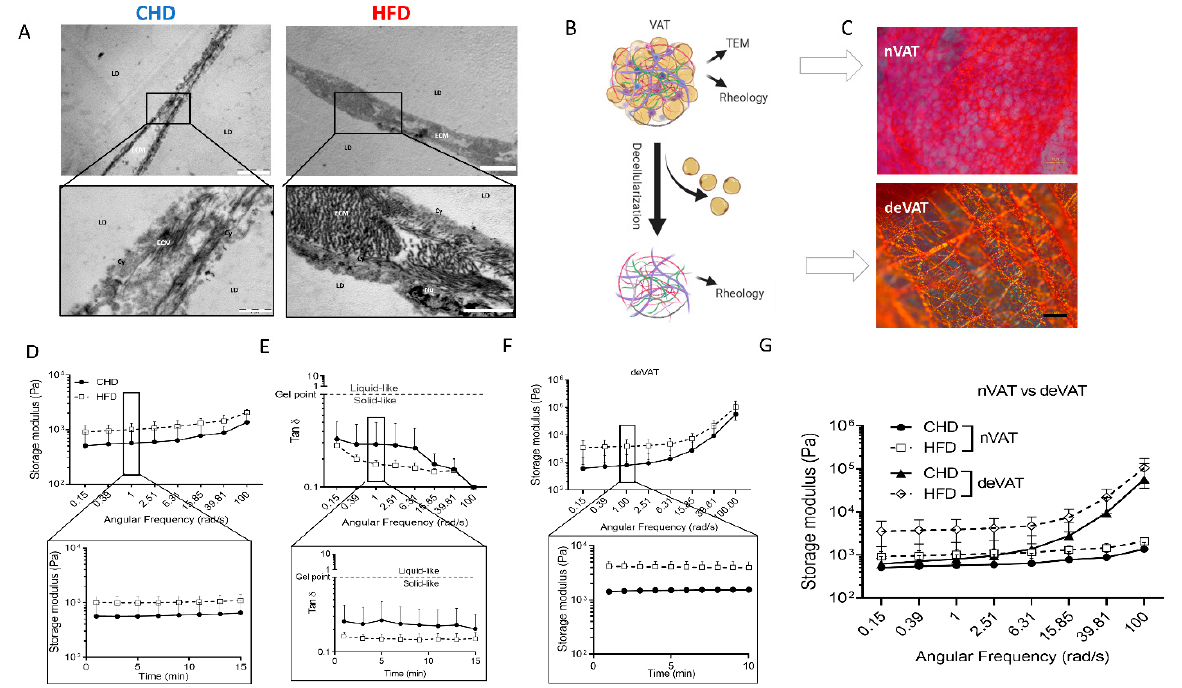
Figure 2. ECM mass and stiffness increase in VAT from HFD-fed mice. ( A ) TEM images of VAT to visualization of LDs, a thin layer of cytoplasm (Cy), and the extracellular space. Lower pictures show the ECM at high-density fibrils from HFD-fed mice, (Scale bar is 5 µ m for top images, 1 µ m for CHD, and 2 µ m for HFD-fed mice at the bottom.) ( B ) Schematic illustration of nVAT and deVAT followed collagen staining and measuring of viscoelasticity and stiffness. ( C ) Picrosirius Red Staining of nECM and deECM collagen fibers in VAT (scale bar = 100 µ m) ( D ) Storage modulus represented by logarithmic range dependent on the angular frequency sweep of mice under HFD (empty symbol, n = 5) and CHD (solid, n = 4) and the storage modulus over time under a constant angular frequency of 1 rad/ ( E ) Tan δ is dependent on angular frequency sweep or measured under angular frequency of 1 rad/s over time. The dashed grey line represents the gel point in Tan δ . ( F ) The storage modulus of decellularized VAT is dependent on angular frequency sweep for HFD (n = 7) and CHD (n = 6) and the storage modulus overtime under a constant angular frequency of 1 rad/s. ( G ) The storage modulus of nVAT compared to deVAT represents ECM stiffness. Empty symbols represent VAT from HFD-fed mice, while solid symbols are from CHD-fed mice. The error bars are the standard deviation, and the statistical significance is * p < 0.05. The y -axis represents the logarithmic axis in the rheology properties results.